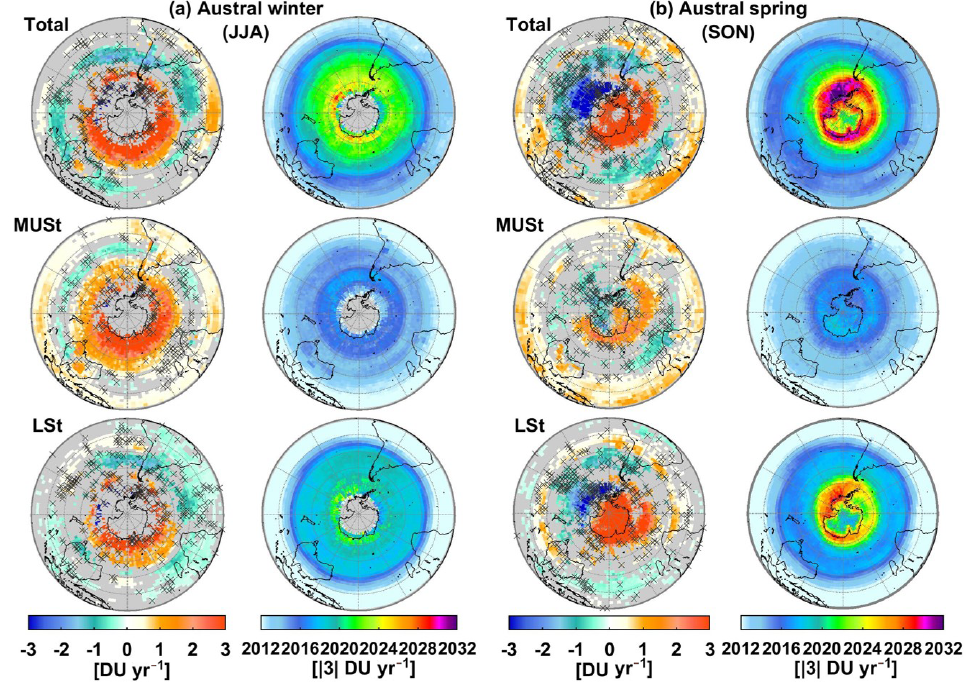
Figure 10. Hemispheric distribution (a) in austral winter (JJA) and (b) in austral spring (SON) of the estimated trends in total, MUSt and LSt O 3 columns (left panels: top, middle and bottom, respectively; in DUyr − 1 ; the grey areas and crosses refer to the non-significant grid cells within the 95% confidence limit) and of the corresponding estimated year for a significant trend detection (with a probability of 90%) of a given trend of | 3 | DUyr − 1 starting at January 2008 (right panels: top, middle and bottom, respectively).